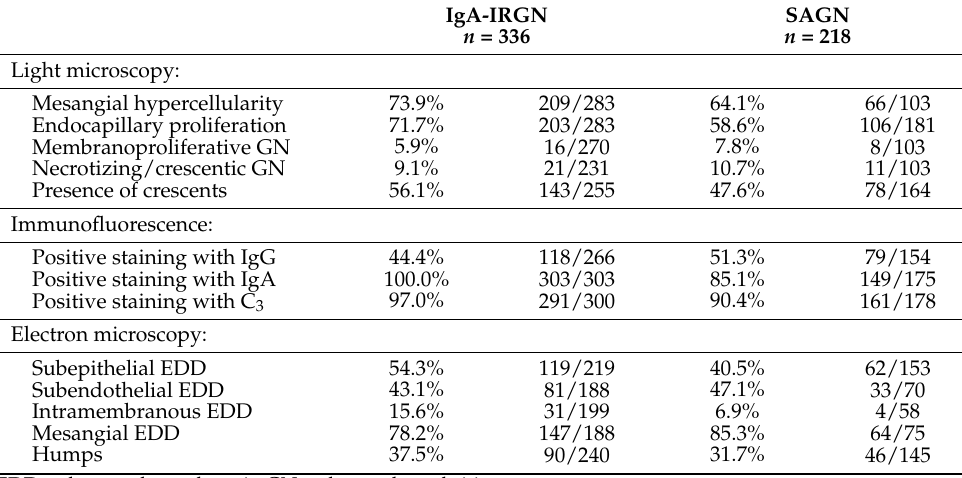
Table 4. Histological findings of the reported patients with IgA-IRGN or